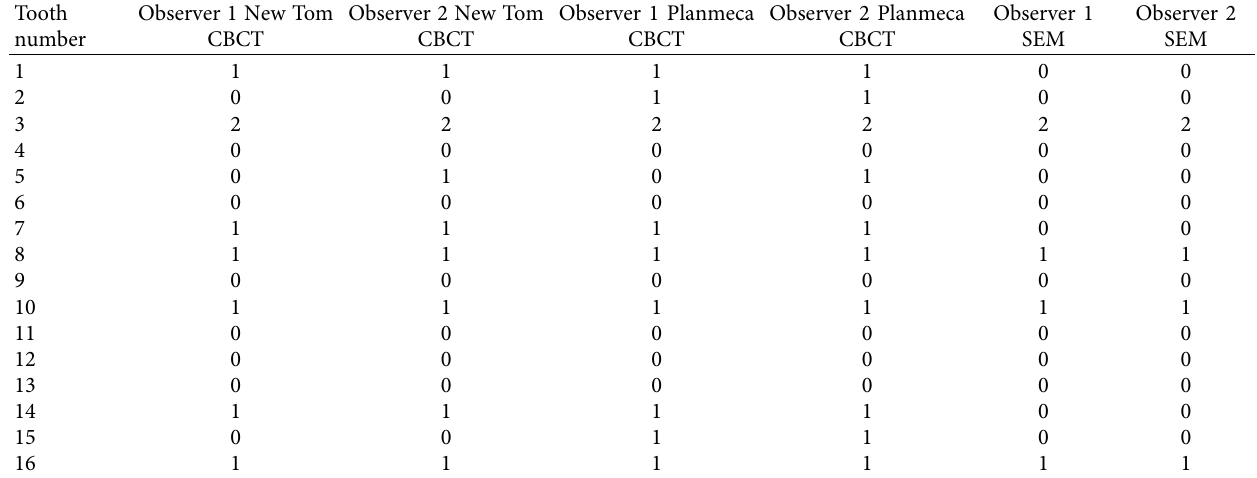
Table 1: The scores of leakage along the gingival wall of restorations in CBCT units and SEM. Tooth